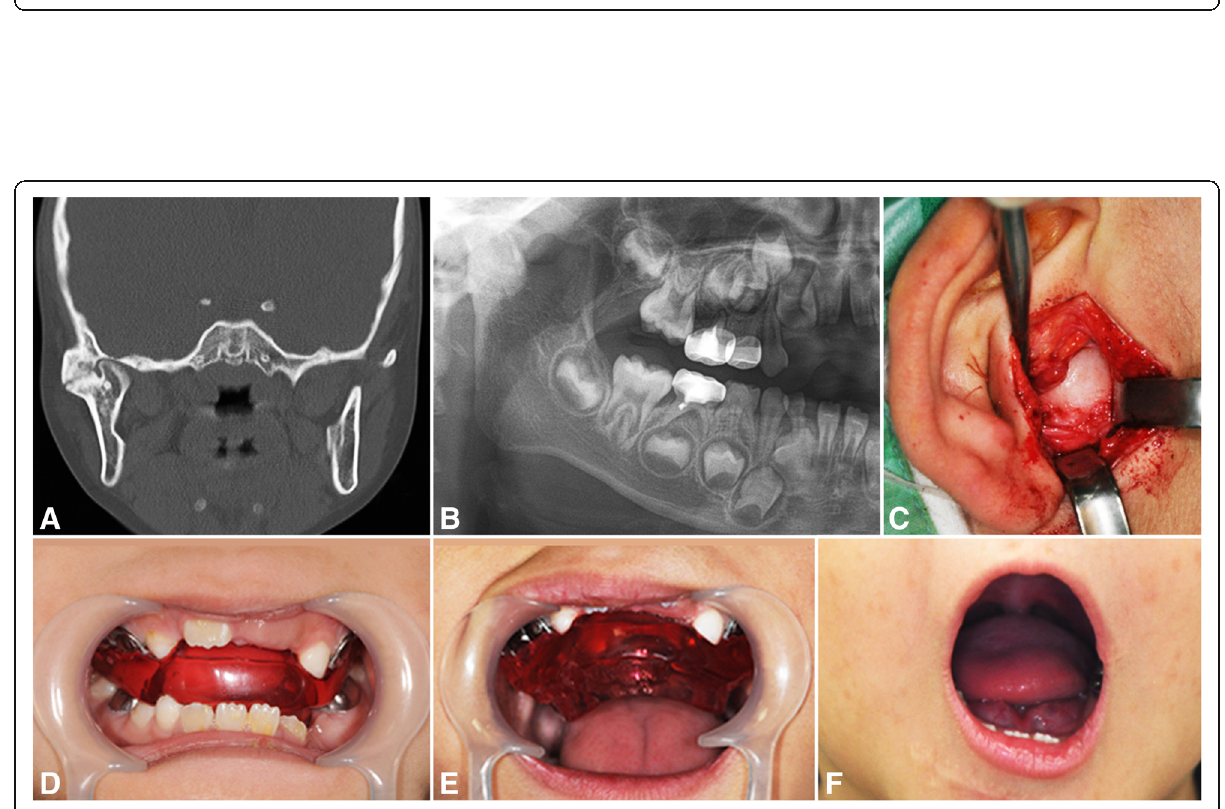
Fig. 2 A 15-year-old female, idiopathic right side TMJ bony ankylosis, showing coronal CT scan ( a ), preoperative panoramic view ( b ), endaural approach with ankylosed mass resection ( c ), interocclusal splint retained on the maxillary screws ( d ), active mouth opening exercise with maximal interincisal opening ( e ), and mouth opening appearance after 6.5 years ( f )